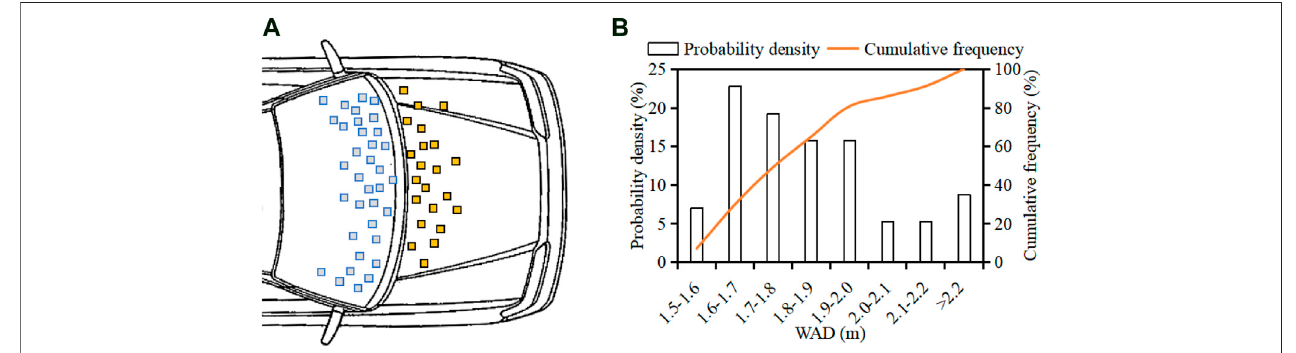
FIGURE 7 | Distribution of pedestrian head-to-vehicle contact location (A) and WAD (B)